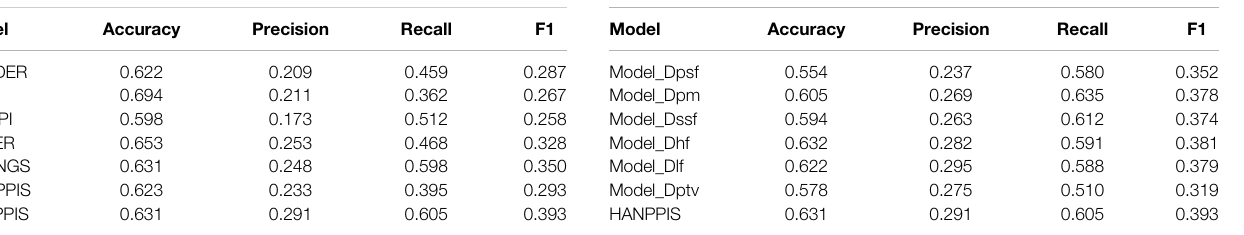
TABLE 1 | Model compares the experimental results on the test set. TABLE 2 | Results of ablation